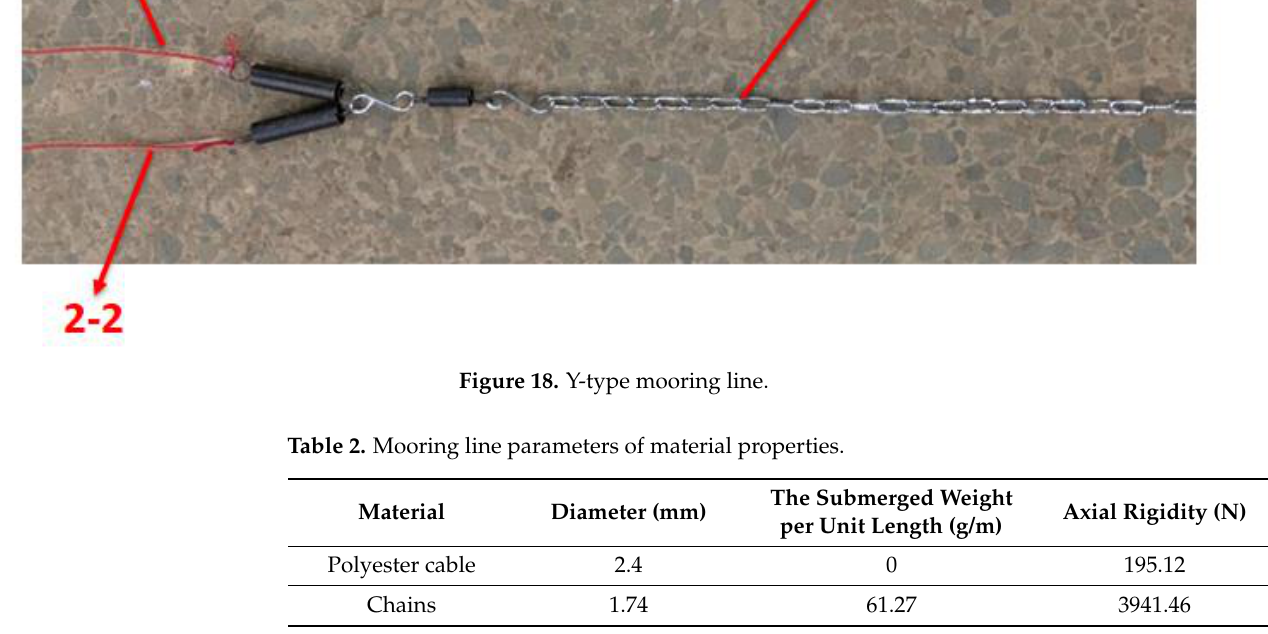
Table 3. Mooring line parameters of geometric properties.